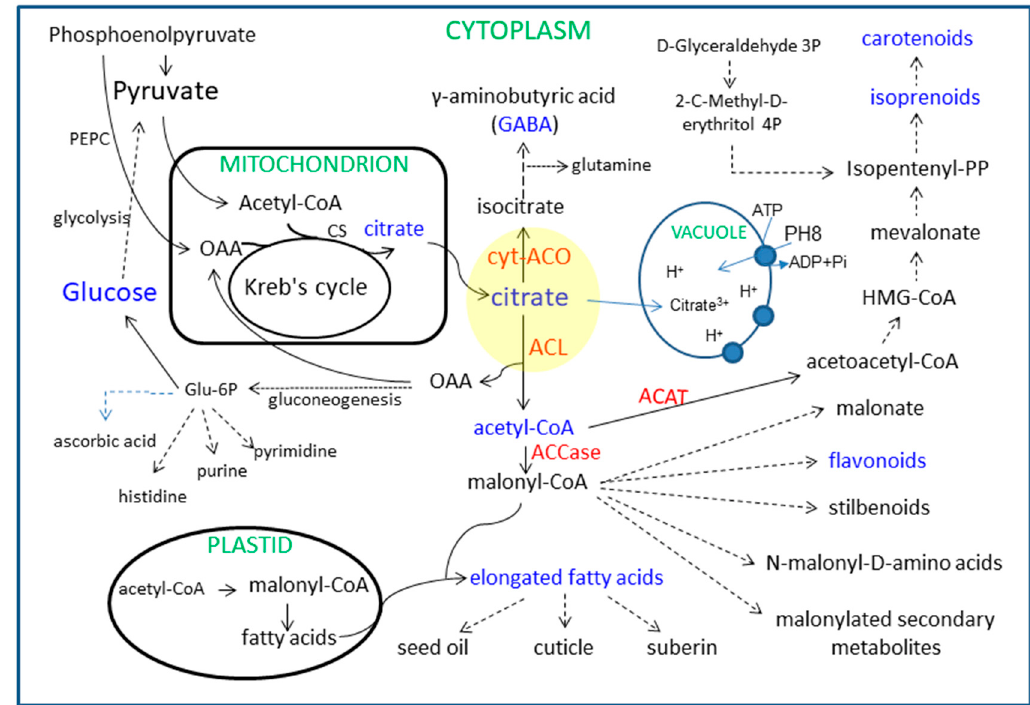
Figure 1. Schematic illustration of the network for metabolite connection in the plant cell. Yellow circle protrudes the crossroads of several pathways. Red letters indicate the key enzymes in the metabolite transformation and blue letters show the main metabolites. ACL refers to ATP-citrate lyase. cyt-ACO refers to cytosolic aconitase. ACAT refers to acetyl-CoA C -acetyltransferase. ACCase refers to acetyl-CoA carboxylase. PEPC refers to phosphoenolpyruvate carboxylase. CS refers to citrate synthase. PH8 refers to a P-type proton pump, CsPH8 [18].